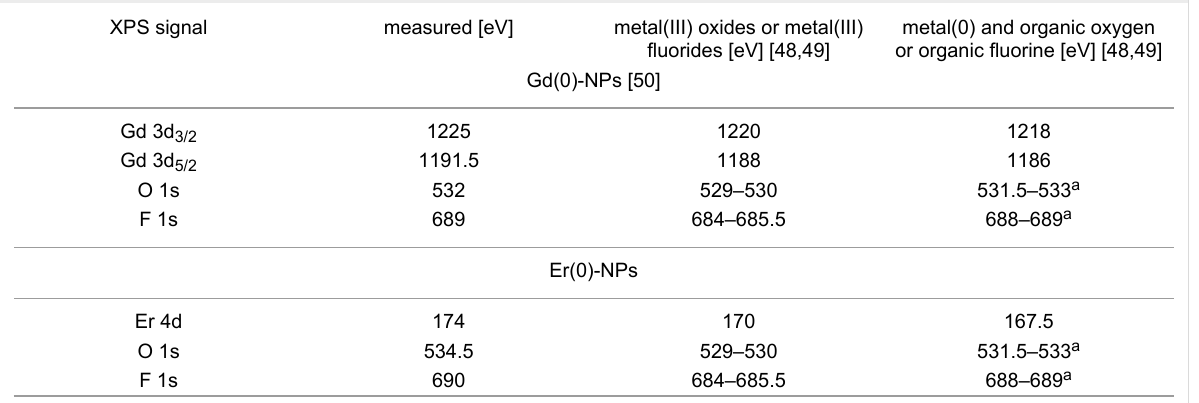
Table 3: Comparison of XPS binding energies in RE-NP samples in [BMIm][NTf 2 ].